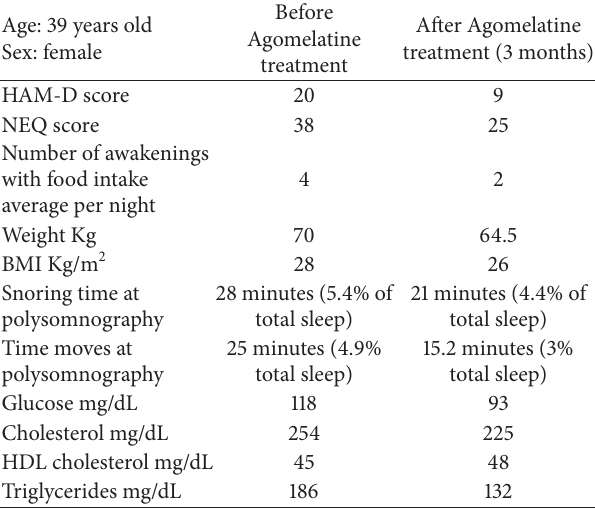
Table 1: The effect of Agomelatine on a NES